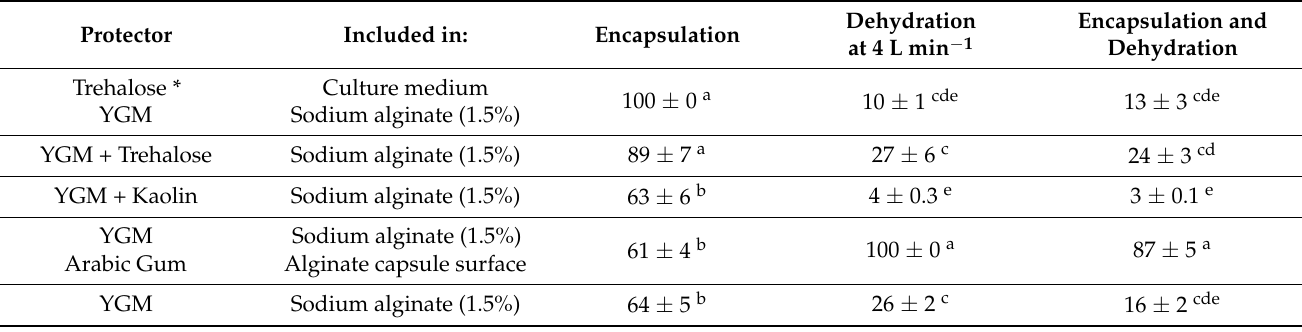
Table 1. Viability (%) of the Streptomyces CDBB1232 mycelium after its immobilization in a calcium alginate matrix and subsequent dehydration.